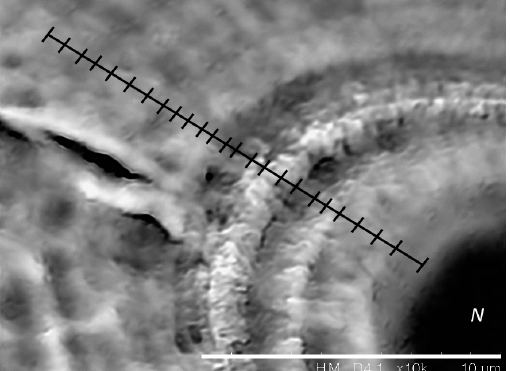
Figure 7. Increment width ( μ m) measured in the otoliths European sardine Sardina pilchardus (Wal ‐ baum, 1792) larvae observed under scanning electron microscope. The bar on top of the image rep ‐ resents the otolith reading counts from the nucleus (N ) to the outer increment, where the small lines are the daily increments. 4. Discussion 4.1. Effect of Temperature on Growth, Survival, and Otolith Development Temperature had a significant effect on larval growth and otolith microstructure, in ‐ cluding deposition rate and the relationship between somatic and otolith growth. This has practical consequences for the application of otolith analysis for the age determination of sardine larvae, for back ‐ calculating length or estimating the growth rate at earlier ages, and for understanding the influence of the environment in these processes. The experi ‐ mental period for larvae in tanks at 13 °C was shorter than the other experimental units since larval survival was reduced at this colder temperature. It has been found that larvae experiencing lower temperatures during the exogenous feeding period had higher daily mortality rates, probably due to the decreased foraging and growth rates at sub ‐ optimal temperatures [35]. On the other hand, within the 13–17 °C range, larvae growth rates in ‐ crease directly with the increasing temperature [35,55,56]. Higher temperatures, by accel ‐ erating the metabolic rates, can influence not only growth rates but especially accelerate ontogeny development [57]. Therefore, larvae experiencing higher temperatures are more active swimmers and begin searching for food earlier than larvae experiencing lower tem ‐ peratures [36,37].